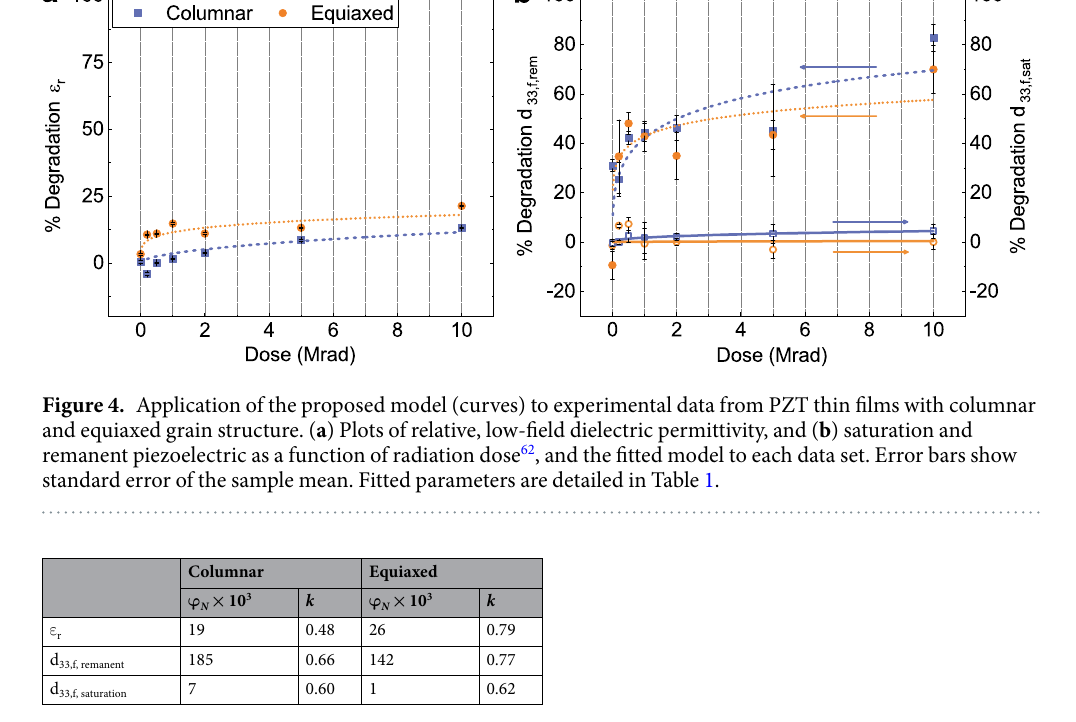
Table 1. Extracted parameters from application of phenomenological model to TID studies. Shown are dielectric permittivity and effective longitudinal piezoelectric response in gamma-irradiated PZT thin films. Data is extracted by fitting Equation (8) to percent change of given functional response measurement vs. radiation dose. Note that values of ϕ N are multiplied by three orders of magnitude to make interpretation more